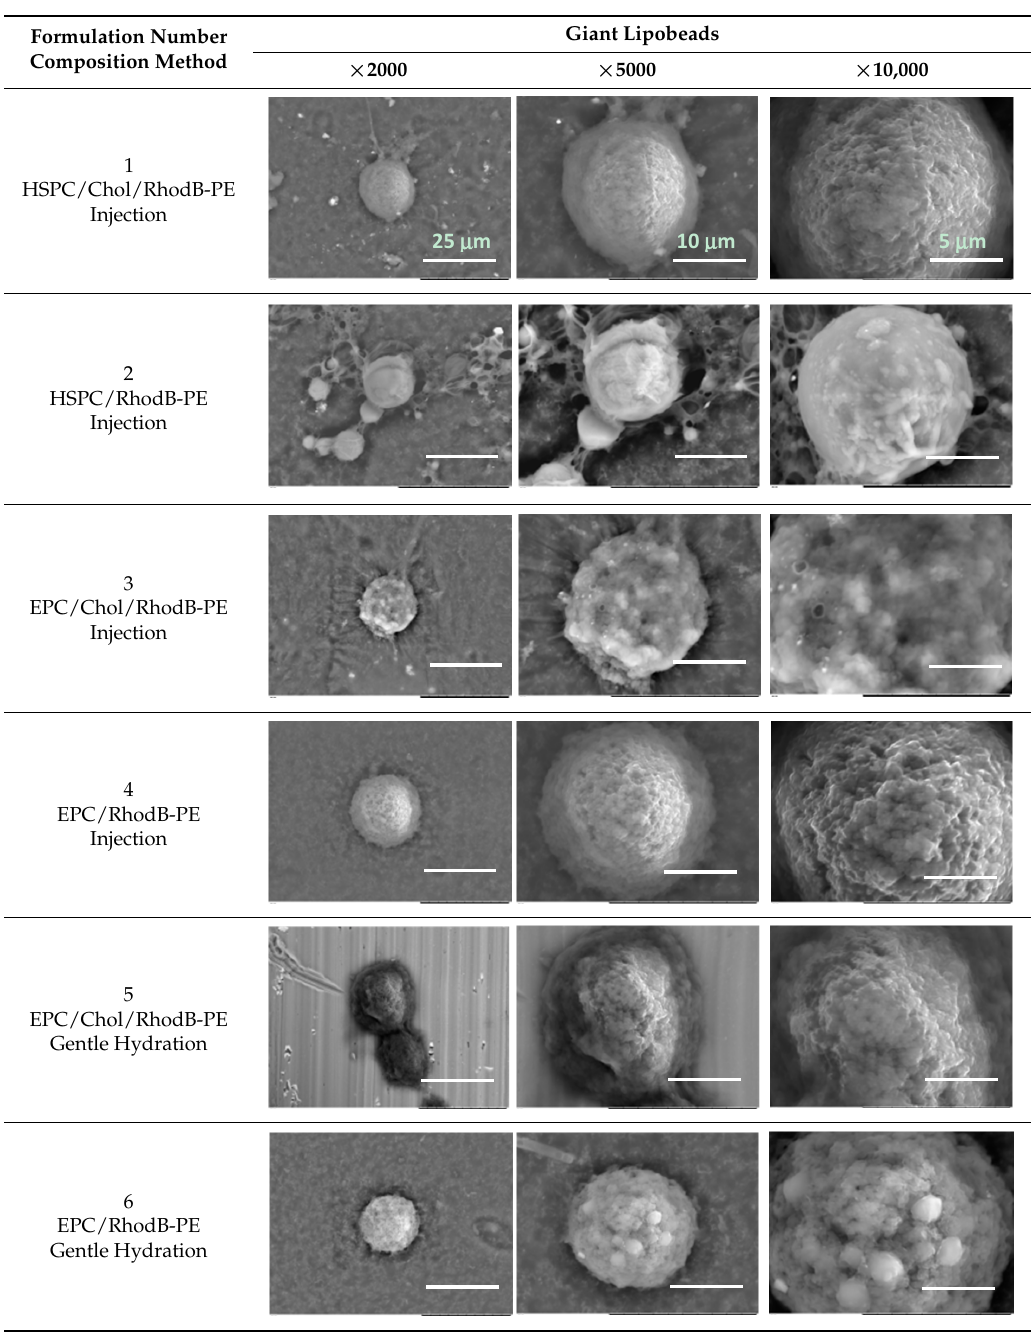
Table 2. Structure and morphology of giant lipobeads prepared by incubation of giant multilamellar vesicles (GMVs) and microgels as imaged by the high vacuum SEM at three different magnifications (the scale bars correspond to all images in the same column).